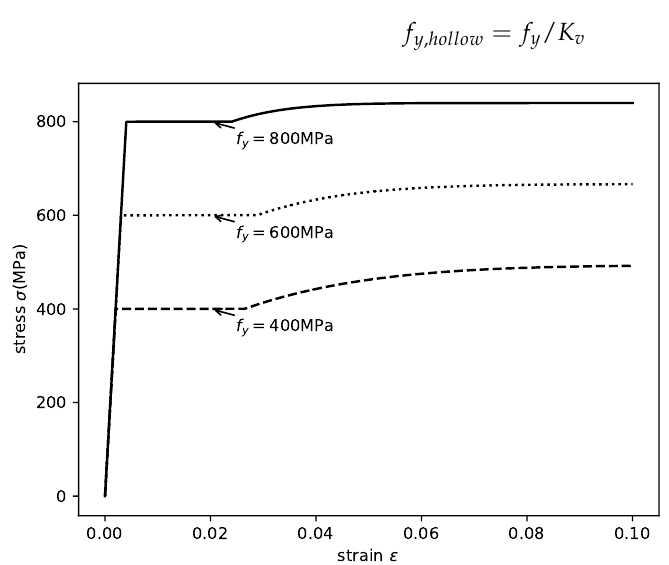
Figure 10. Axial stress–strain relationships of structural